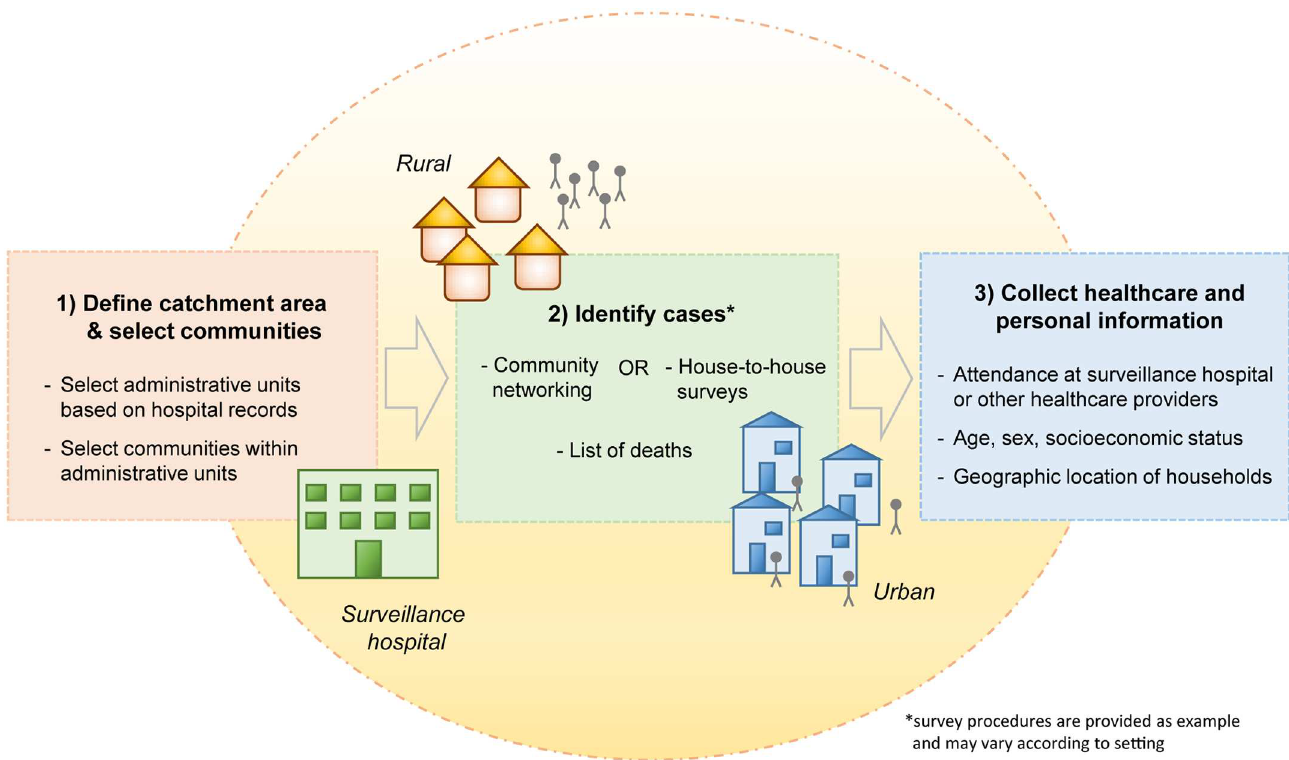
Fig 1. Key steps of the collection of healthcare utilization data to evaluate the sensitivity and representativeness of surveillance systems. In the Bangladeshexample,the catchment areas of surveillance hospitalswere first definedbased on hospitalrecords (e.g., areas where > 50% or > 75% of cases reside) [13,14].Subsequently, small administrative units were chosen at random from within the catchment area, and all communities in the selectedareas were surveyed.Cases in the community were identified based on lists of deaths in additionto community networkingstrategies (rural settings) or house-to-house surveys (urban settings). Information on symptoms (to establish case definitions), healthcareseekingbehavior, and characteristics of cases was collected.In other settings, the exact survey procedures may vary accordingto the context.